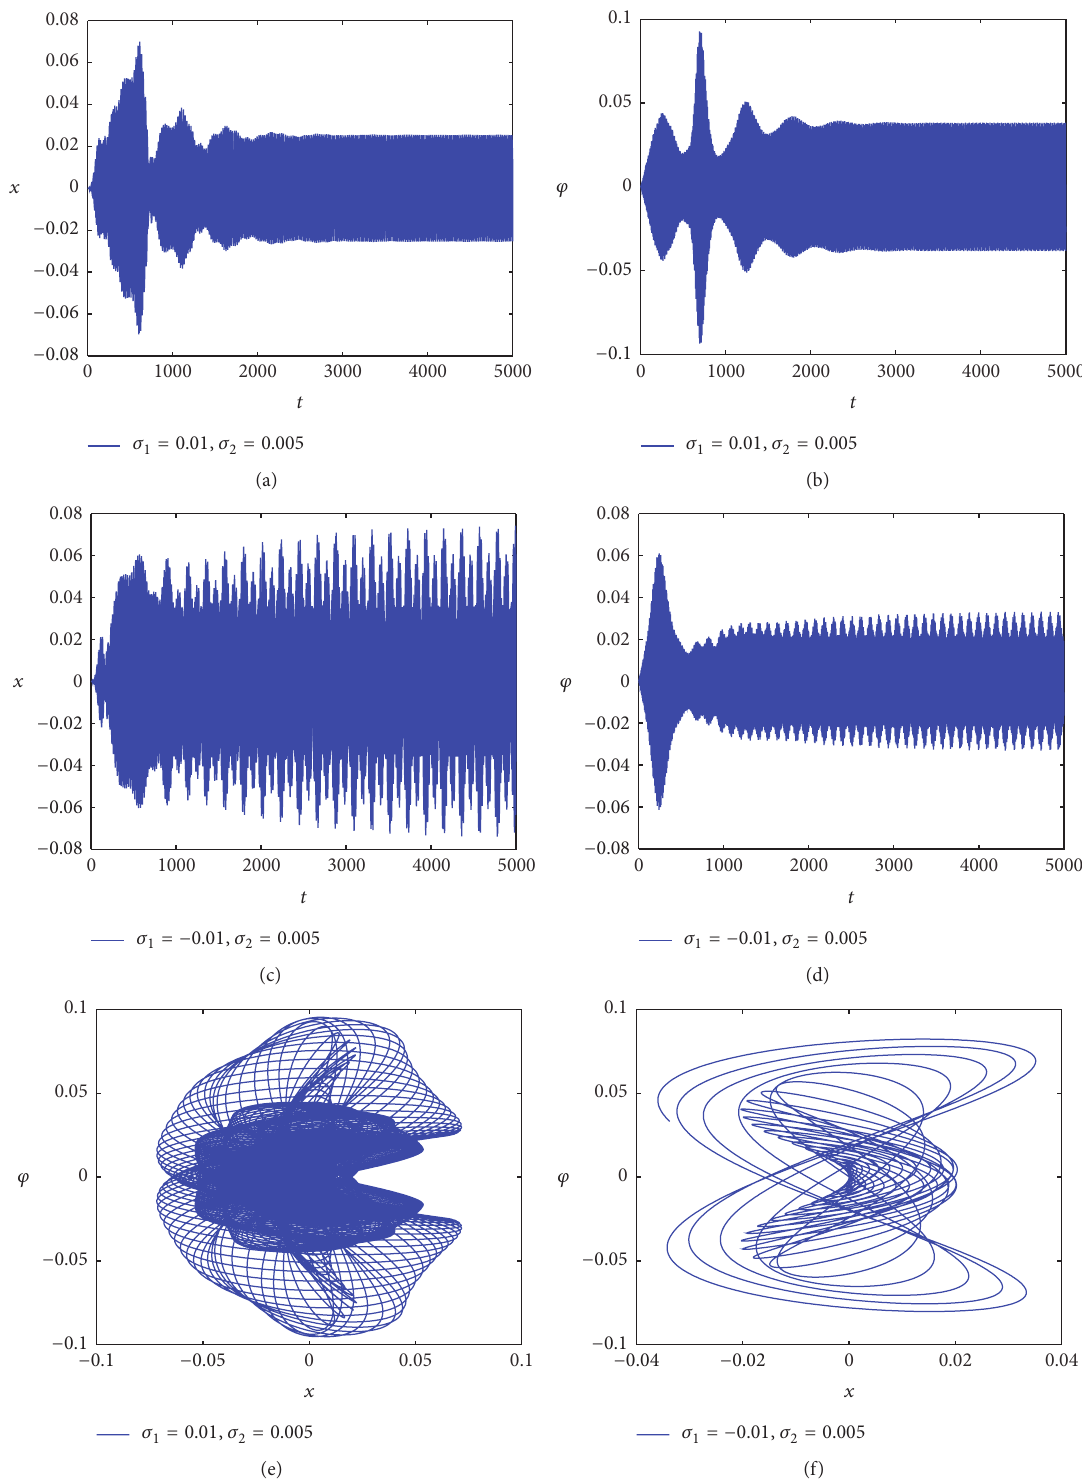
Figure 13: Parts (a), (b), (c), and (d) represent the portraits of time history, while parts (e) and (f) symbolize the projections of the phase planes at 𝑎 = 𝑏 = 𝑟